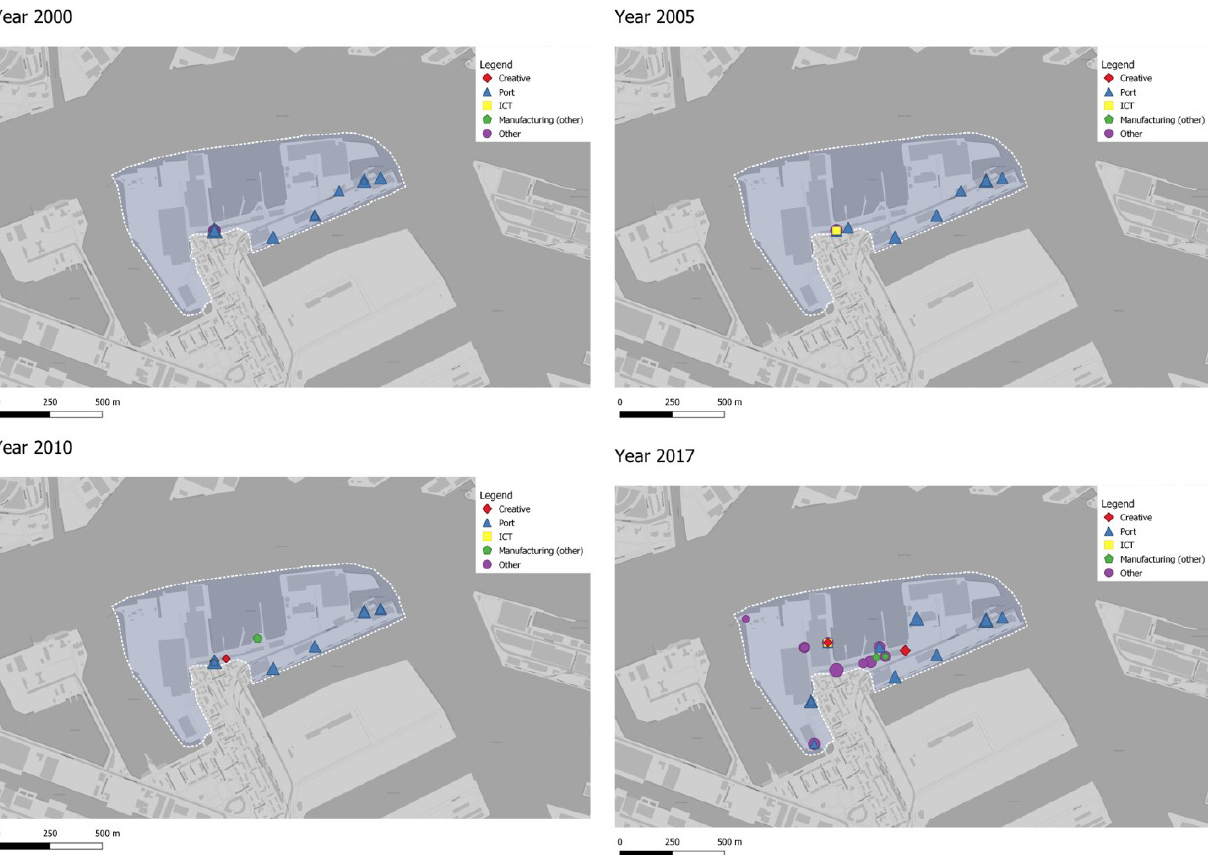
Figure 5. Companies in RDM by sector, 2000–2017. The symbol size represents the number of jobs. Source: Figure by Erasmus UPT (2020), based on LISA (2017) and Publieke Dienstverlening op de Kaart